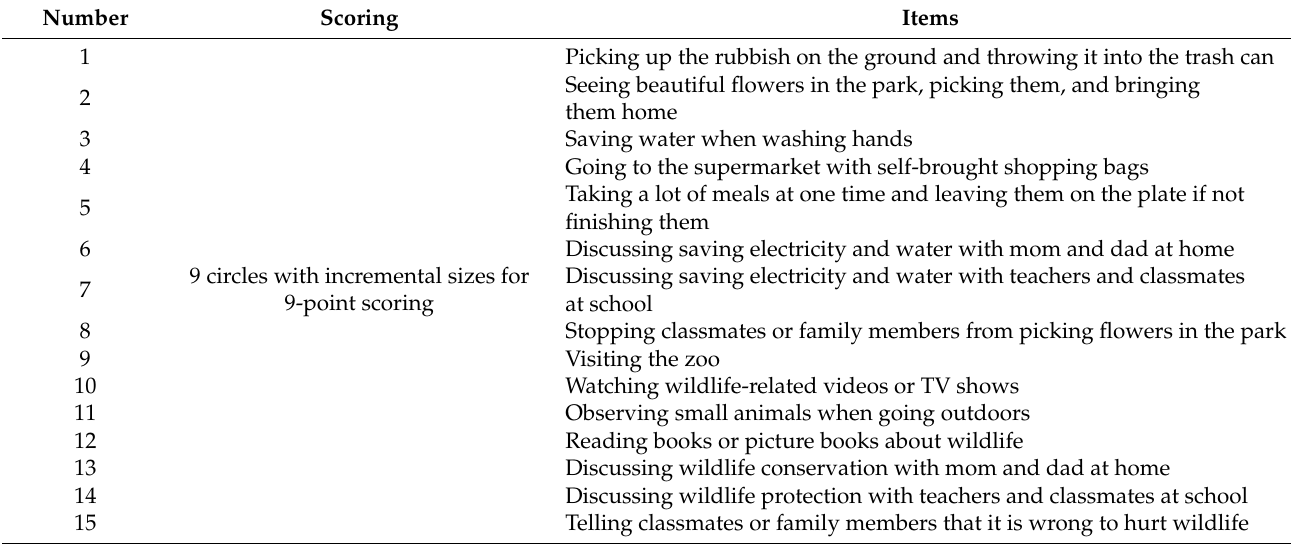
Table A3. The scale of children’s pro-environmental behavior intention.